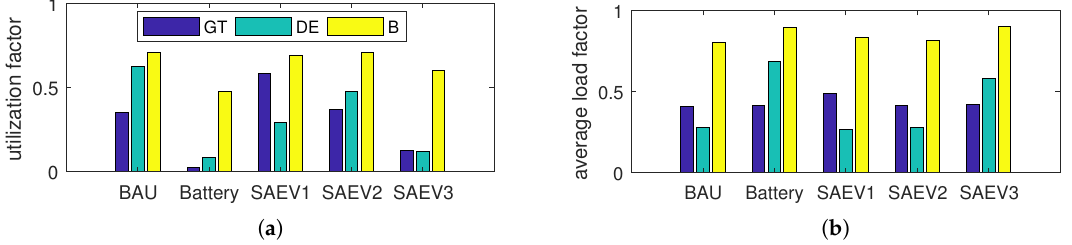
Figure 10. Microgrid distributed generators use: ( a ) utilization factor and ( b ) load factor for gas turbine (GT), diesel engine (DE), and biomass (B) in the microgrid case.